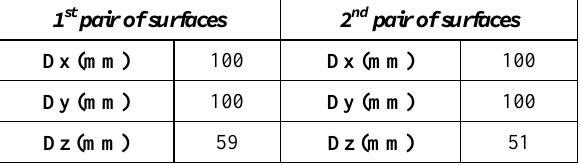
Table 5. Dimensions of the simulation surfaces